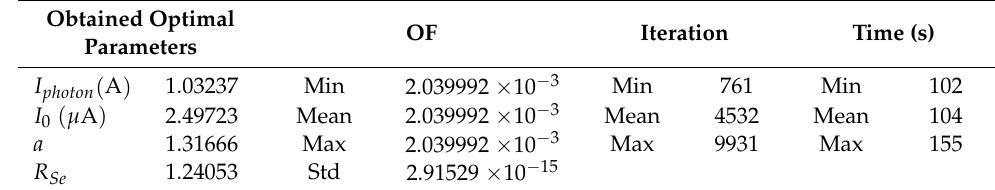
Table 7. Obtained statistical results for SDM PV module.